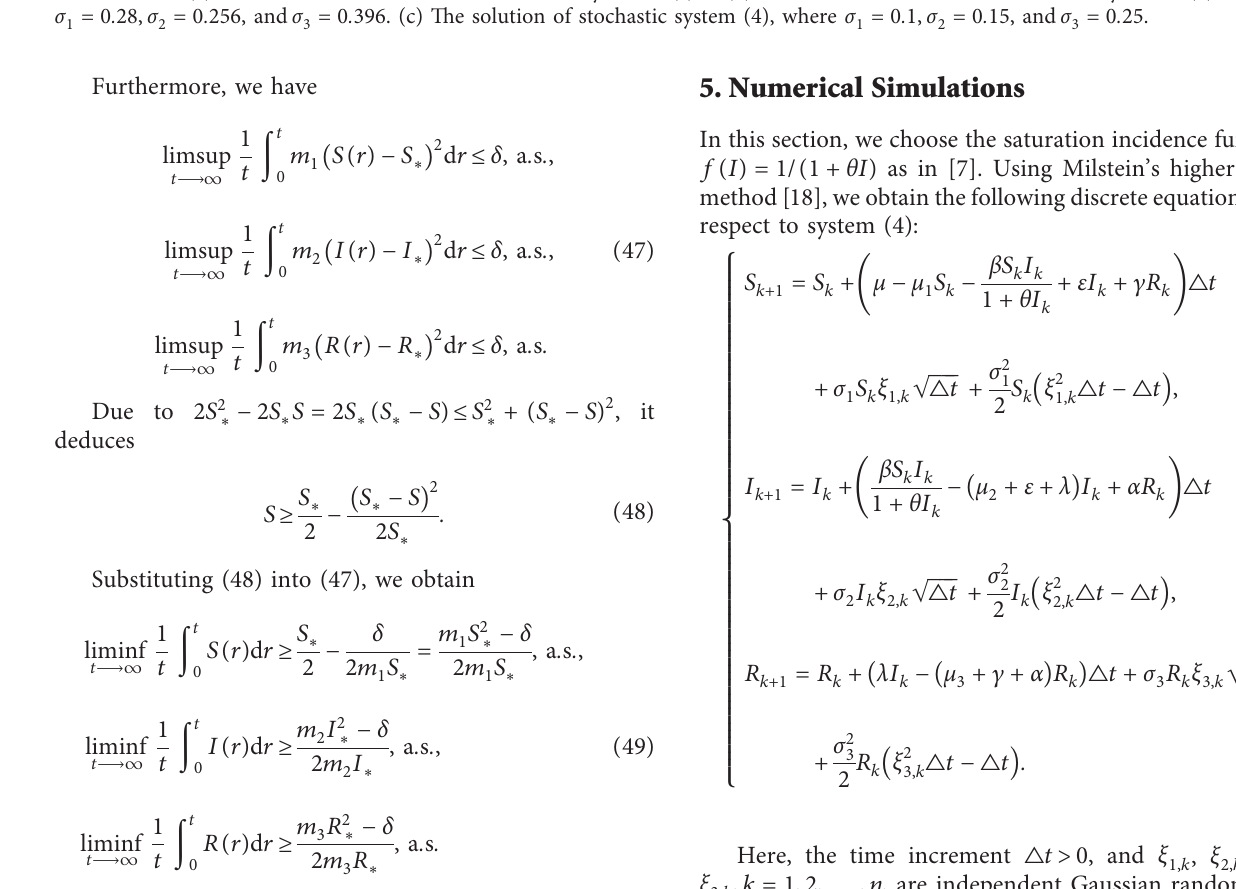
The solution of deterministic system